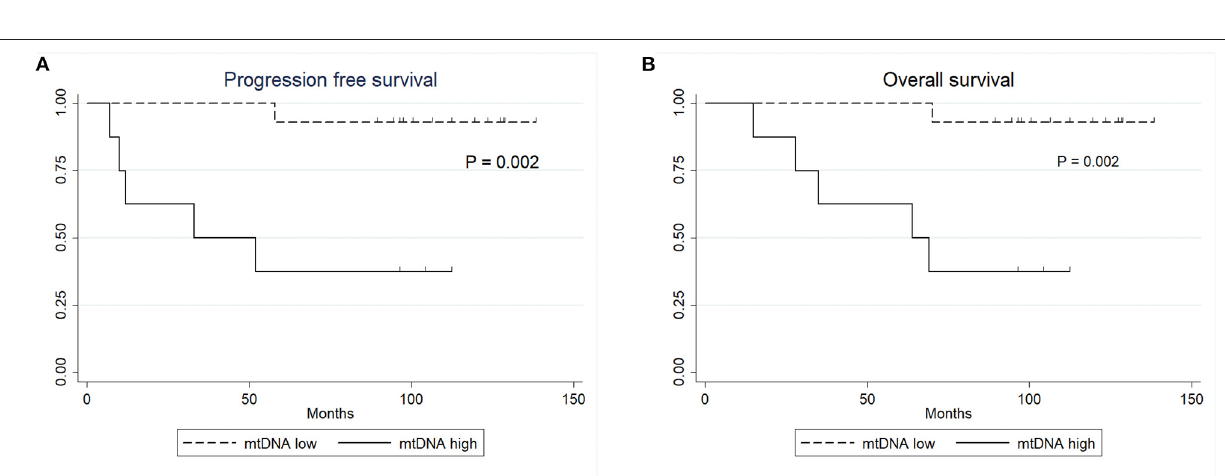
FIGURE 4 | Kaplan-Meier survival curves. (A) PFS of patients with ER negative status by mtDNA content. (B) OS of patients with ER negative status by mtDNA